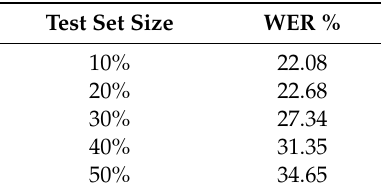
Table 4. Mean WER% for di ff erent validation dataset size.